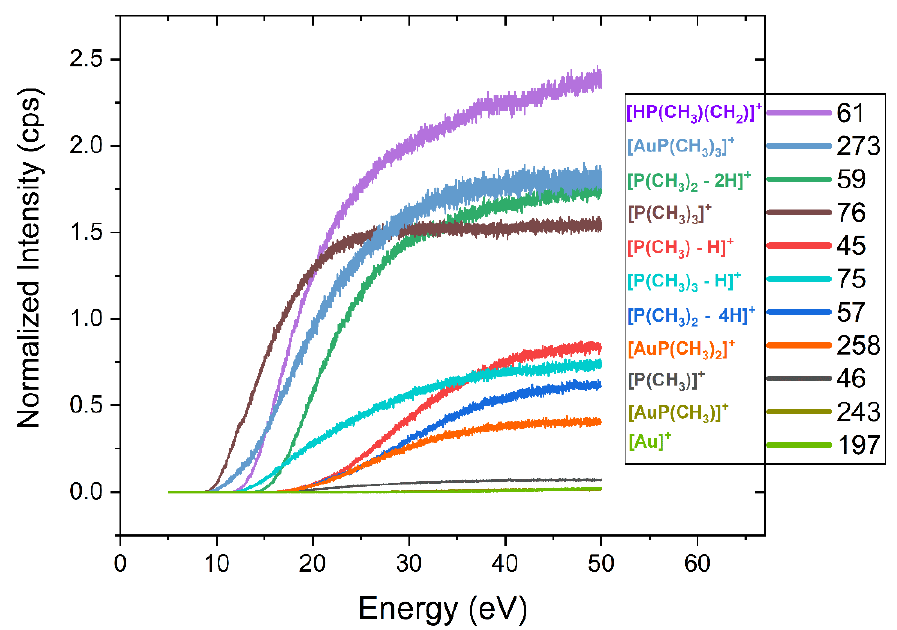
Figure 5. Ion yields for the main positively charged fragments in DI of (CH 3 )AuP(CH 3 ) 3 . The ion yields are shown in the incident electron energy range from below the respective thresholds up to 50 eV. All ion yields are normalized with respect to the pressure and the signal intensity of Ar + from Ar at 50 eV incident electron energy.